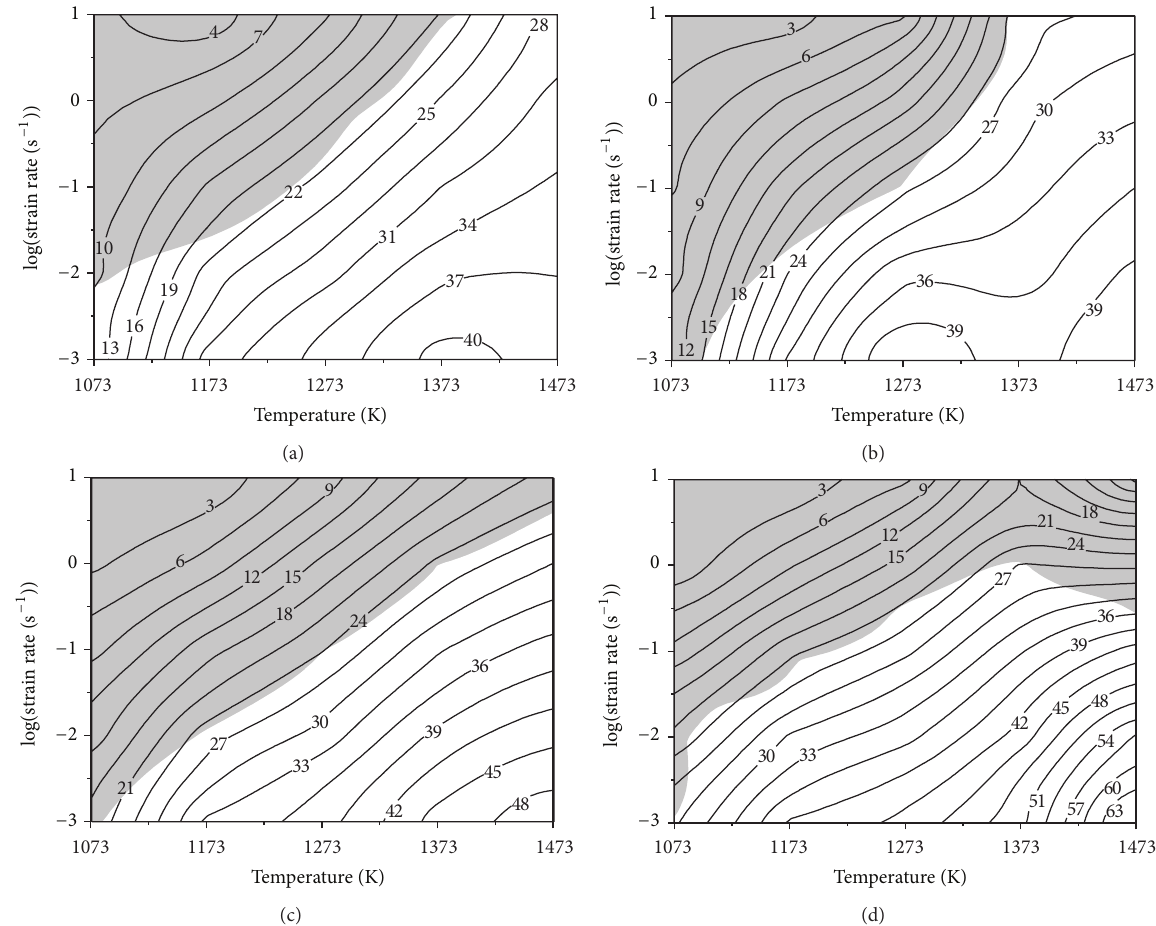
Figure 6: Processing maps obtained on 316LN steels at different strains. (a) 08N, 0.4; (b) 08N, 0.8; (c) 17N, 0.4; (d) 17N, 0.8. (𝑍 𝜀 = 0.136 ln 𝐴) + 𝑐